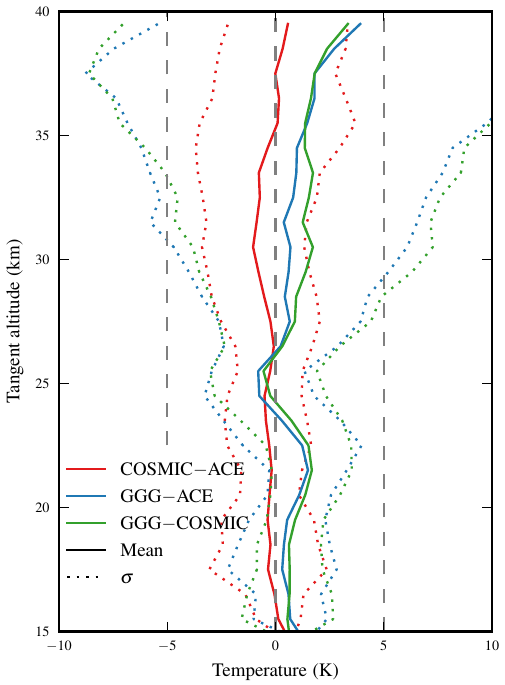
Figure 9. Mean and standard deviations of the differences in retrieved temperature between temperature profiles retrieved by GGG, ACE-FTS v3.5, and COSMIC for all 74 occultations in Fig. 8. Shown are COSMIC − ACE (red), GGG − ACE (blue), and GGG − COSMIC (green). Means are solid lines, and standard devi- ations are